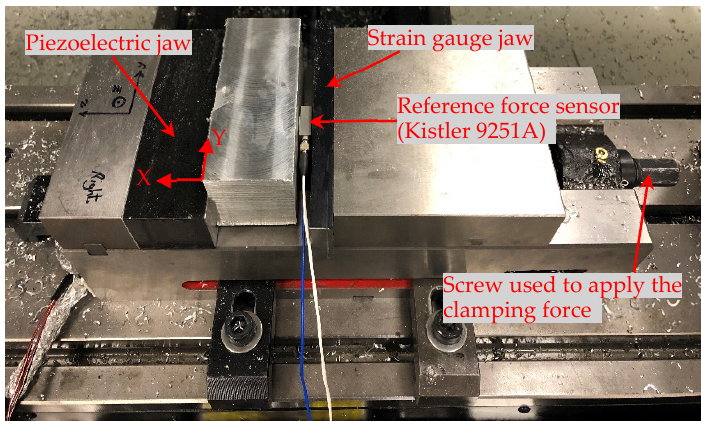
Figure 11. Jaw design with built ‐ in piezoelectric sensors.